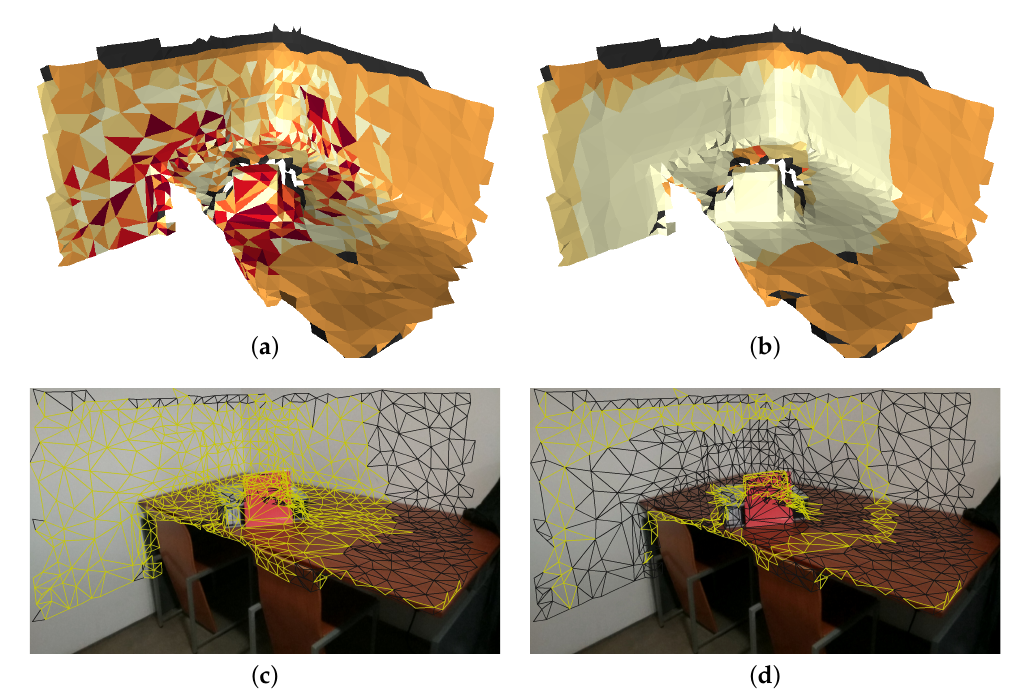
Figure 8. The meshes colorized according to the selected camera are shown for the random criteria ( a ) and the propagation criteria ( b ). Results of border face detection (yellow painted faces) using random criteria for camera selection ( c ); propagation criteria for camera selection ( d